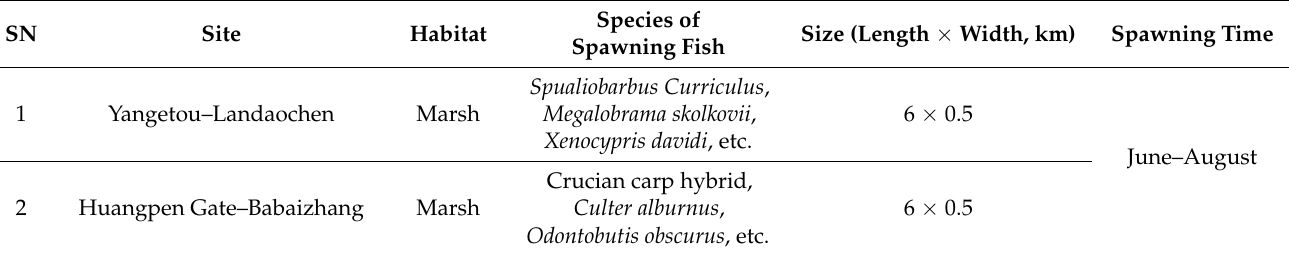
Table 1. Distribution of the spawning grounds in Shengjin